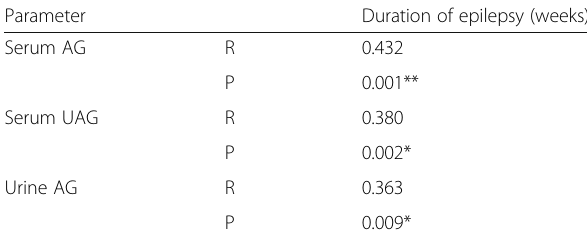
Table 5 Correlation between all measured laboratory parameters and duration of epilepsy Parameter Duration of epilepsy